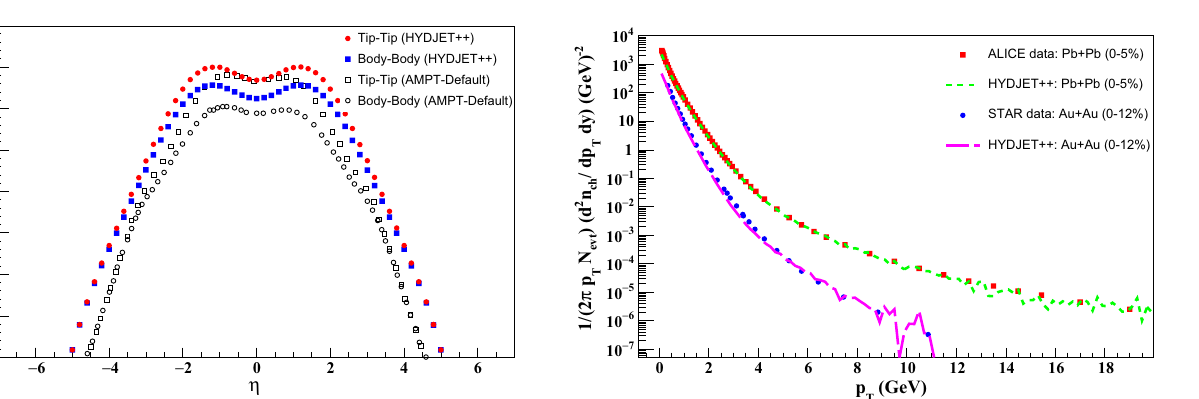
Fig. 15 Variation of normalized transverse momentum distribution of positively charged pions in Au + Au and charged pions Pb + Pb colli- sions for most central class. We have plotted the experimental data from Refs.